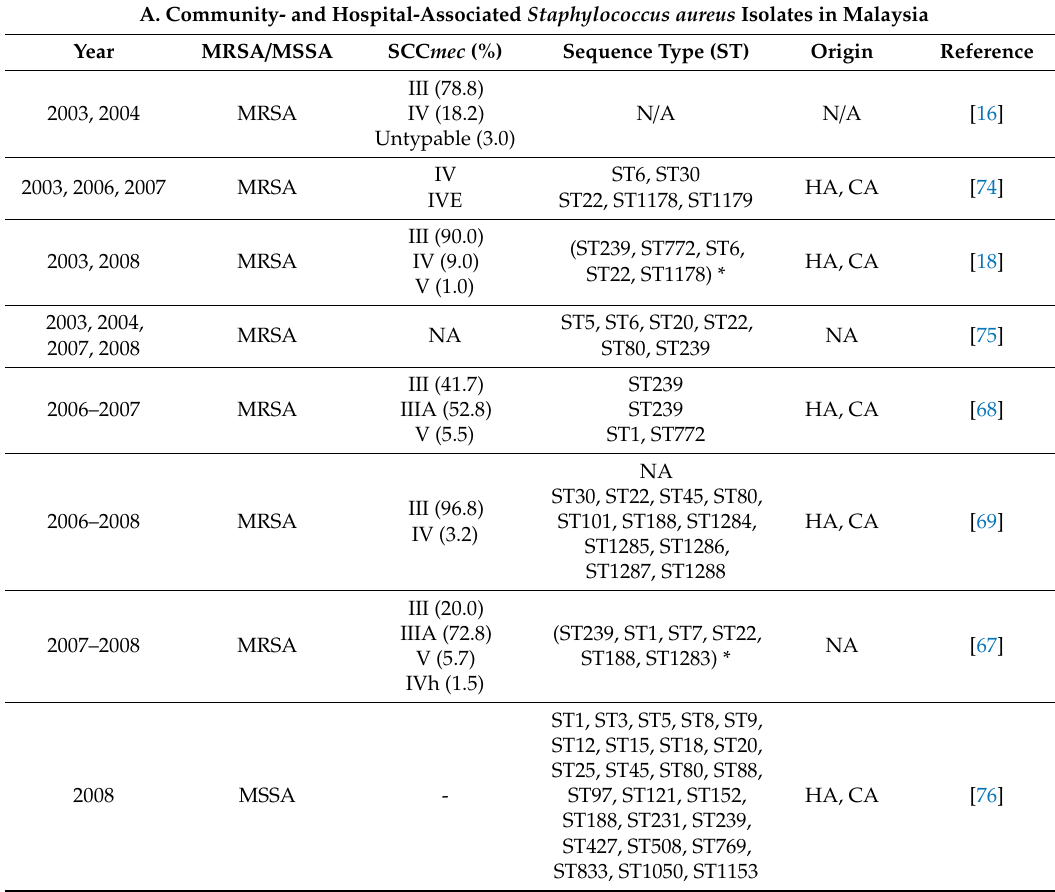
Table 3. Clonal characteristics of Staphylococcus aureus isolates in